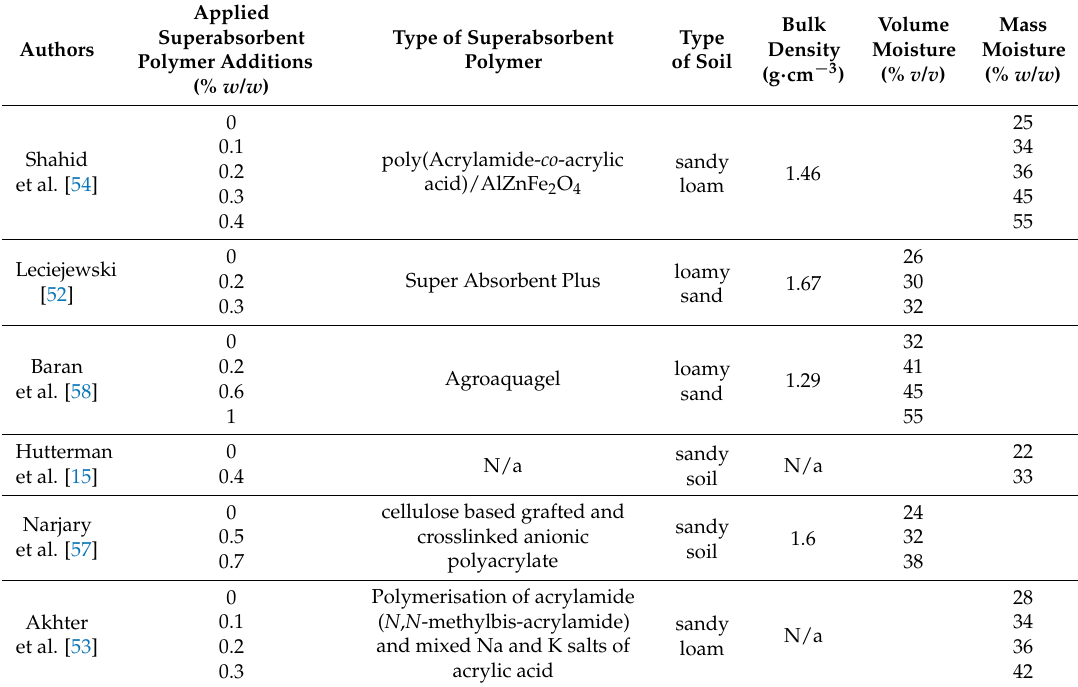
Table 3. Comparison of results of superabsorbent polymer usage as a soil